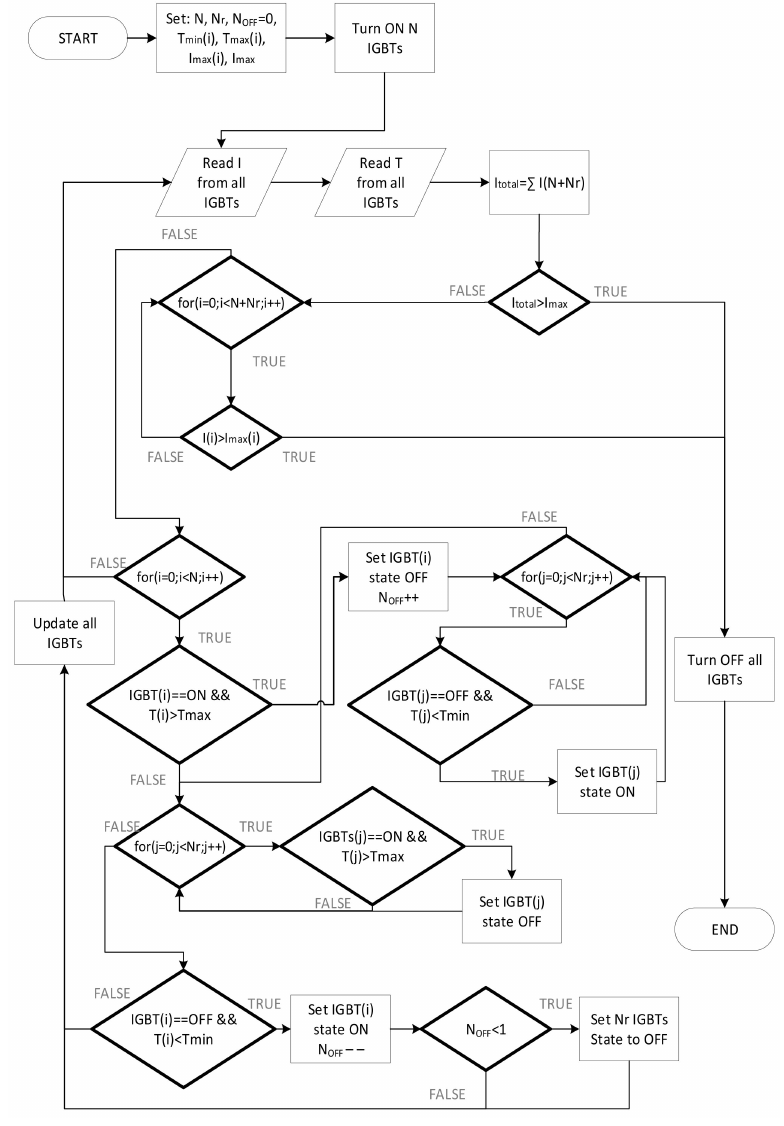
Figure 5. Flowchart of the NNr